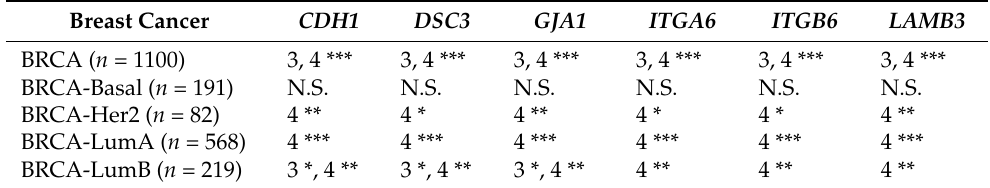
Table 1. Clinical relevance of gene expressions across various cancer types analyzed by the disease stage factor. Breast Cancer